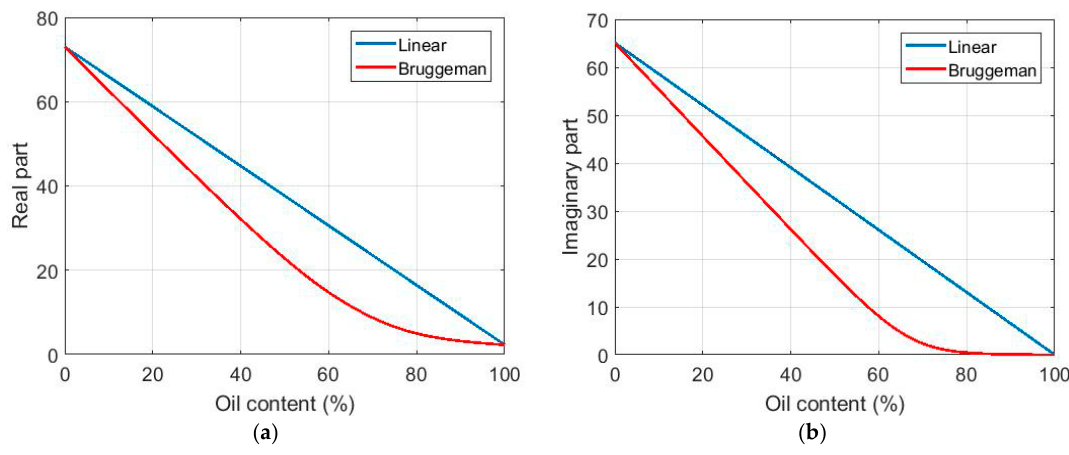
Figure 1. Effective dielectric constant of an oil-in-water emulsion plotted by increasing oil content using a linear model (blue) and the Bruggeman’s model (red): ( a ) real part; ( b ) imaginary part.